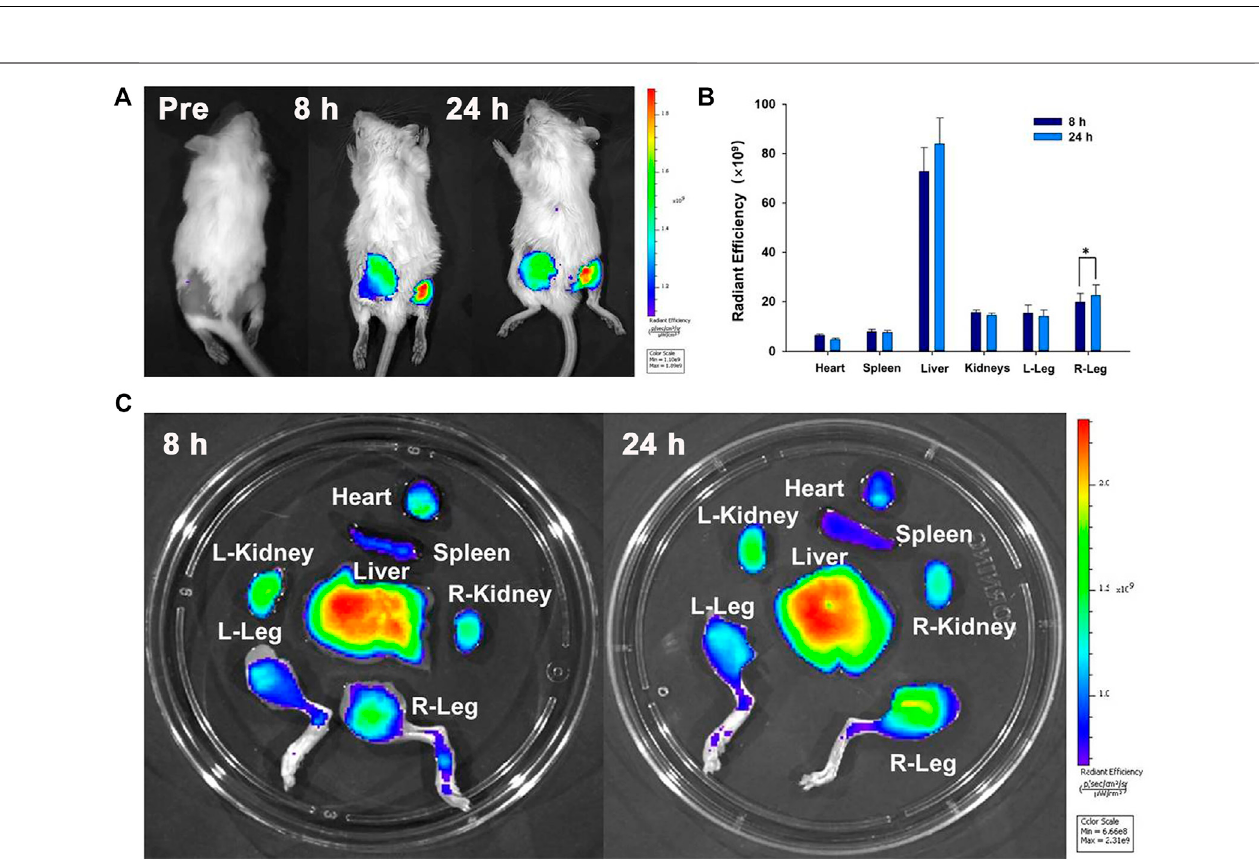
FIGURE 5 | (A) Time-lapse NIR fl uorescence images of MRSA-infected mice in vivo after injection of IR780@PLGA nanoparticles. (B) Averaged ex vivo NIR fl uorescence intensities and (C) NIR fl uorescence images of major organs and legs in MRSA-infected mice; the fl uorescence of the right leg 24 h postinjection was signi fi cantly higher than that at 8 h postinjection (* p <